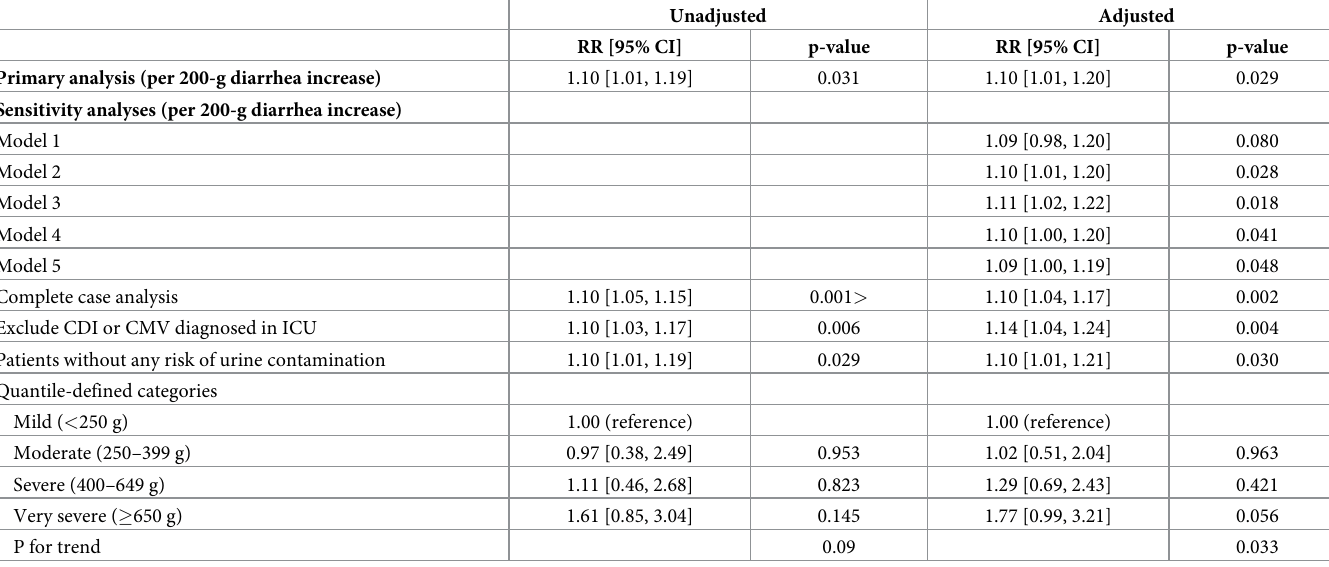
Table 3. Association between the quantity of diarrhea and in-hospital mortality.